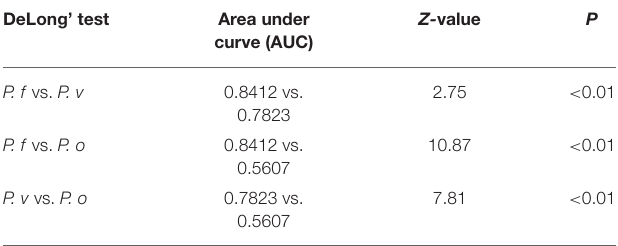
TABLE 3 | DeLong’s test on the technicians’ microscopy ROC.